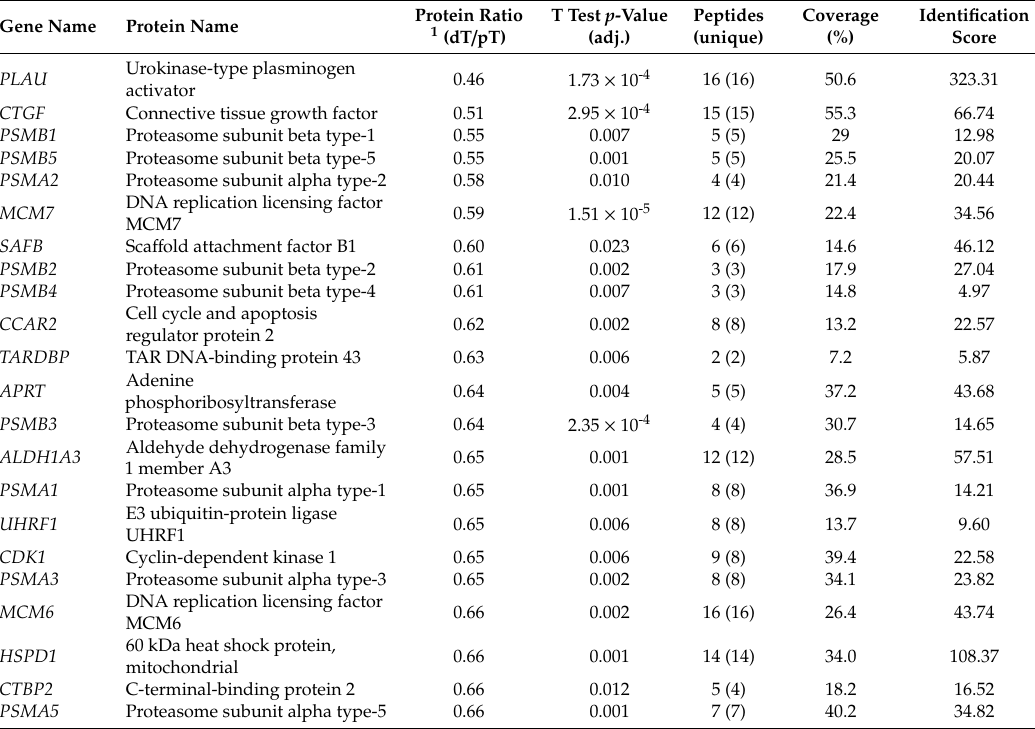
Table 2. 22 Significantly downregulated proteins in dT-EVs.